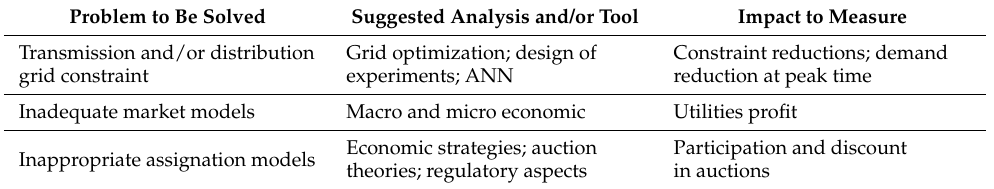
Table 4. Problems, suggestions, and impacts of VPP. Source: own study.